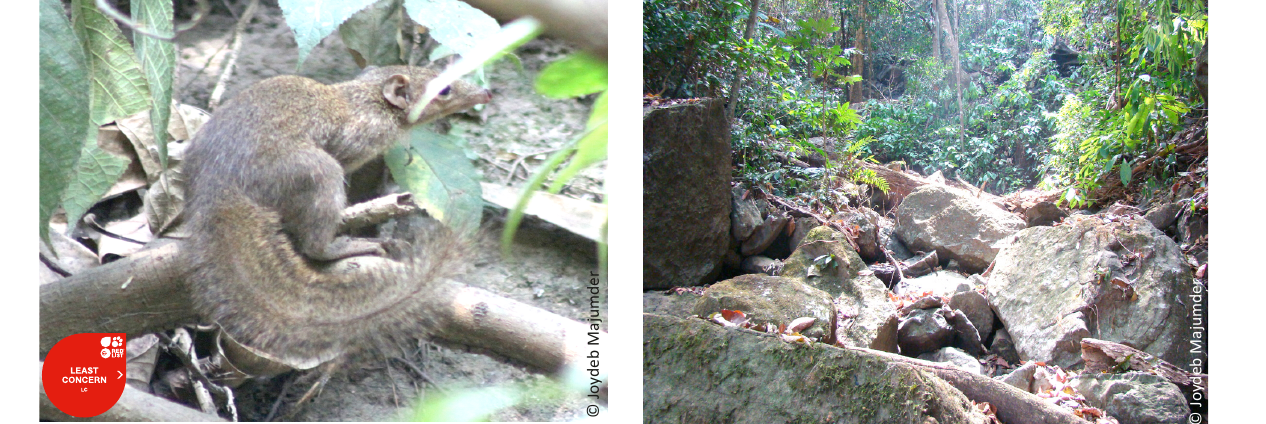
Image 1. An adult of Tupaia